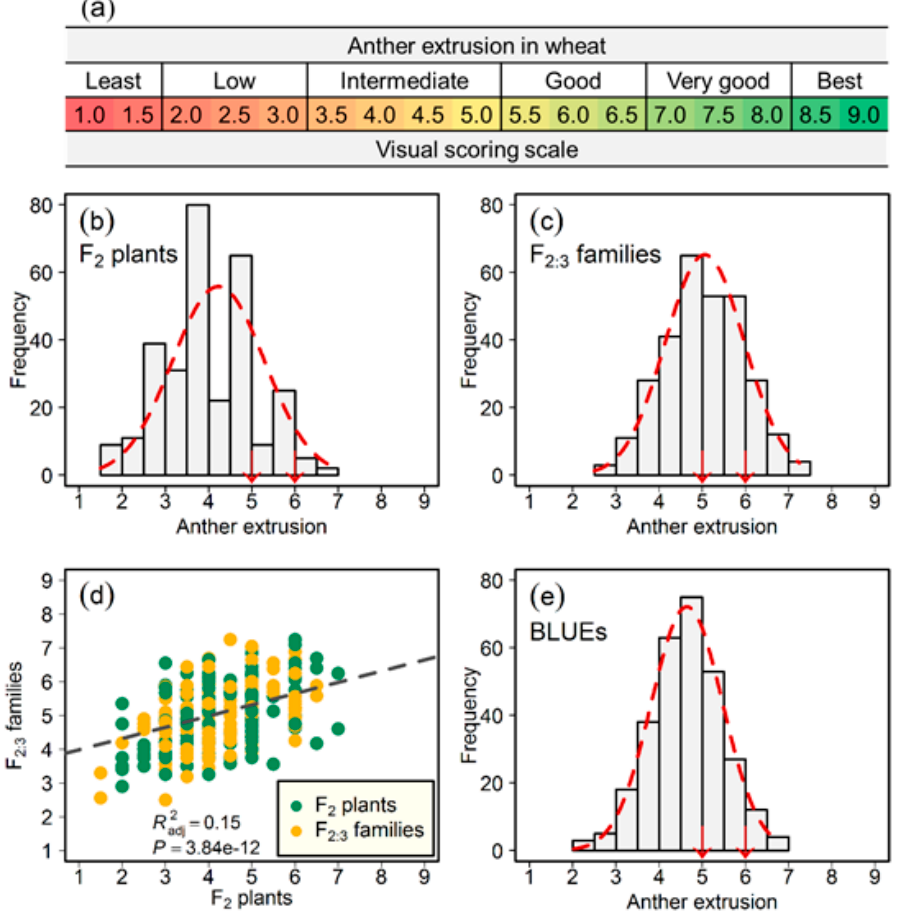
Figure 1. Phenotypic distribution of anther extrusion (AE). ( a ) Scale to visually score anther extrusion in wheat; ( b ) Distribution of AE in the population of 300 F 2 plants; ( c ) Distribution of best linear unbiased estimations (BLUEs) of AE calculated in the population of 300 F 2:3 families; ( d ) Association of AE evaluated in F 2 plants with BLUEs of F 2:3 families; and, ( e ) Distribution of AE’s BLUEs calculated across F 2 and F 2:3 generations. The down arrows mark the performance of the parents. R 2 and P denote the adjusted coefficient of determination and its significance value, respectively.